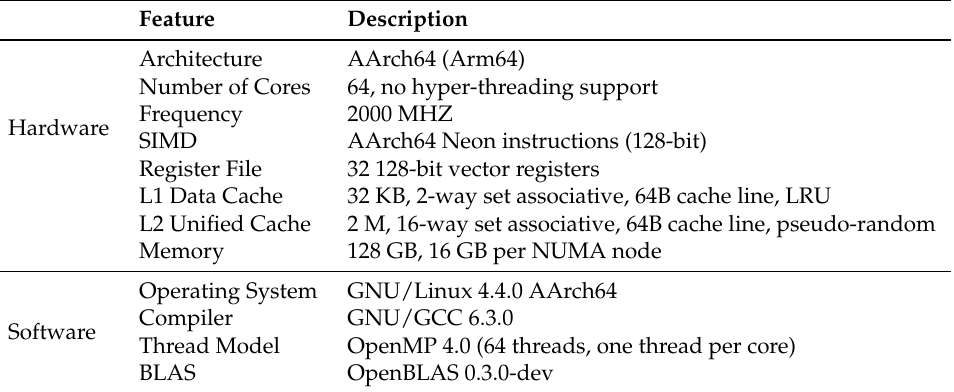
Table 1. Hardware/Software